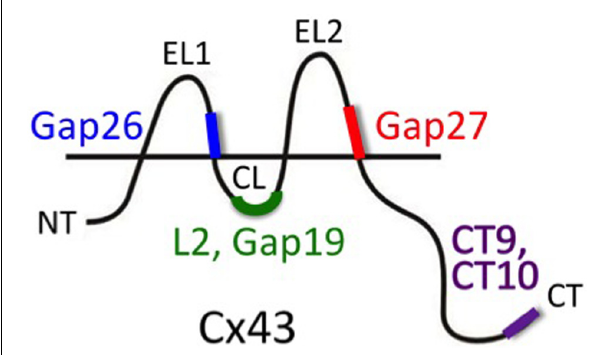
FIGURE 2 | Peptide tools to interfere with Cx hemichannel function. Gap26 and Gap27 are composed of sequences located on the extracellular loops 1 (EL1) and 2 (EL2), respectively (amino acids 64–76 and 201–210, respectively) of Cx43 (mouse).These EL-mimetic peptides first inhibit hemichannels and with some delay also gap junction channels.The sequences they mimic are well conserved between different Cxs and peptides based on Cx43 sequences could also inhibit channels composed of other Cxs (e.g., Cx37). L2 peptide is identical to the L2 domain on the cytoplasmic loop (CL; amino acids 119–144). Gap19 is a nonapeptide located within the L2 domain (amino acids 128–136). L2 and Gap19 peptides block Cx43 hemichannels without blocking gap junctions and without blocking Cx40 hemichannels or Panx1 channels (other Cxs still need to be tested). CT10 and CT9 are the last 10 and last 9 amino acids of the C-terminal end (CT; amino acids 373–382 and 374–382, respectively). CT9/CT10 peptides remove the closure of Cx43 hemichannels with high micromolar cytoplasmic Ca 2 + concentration and thus stimulate the opening of hemichannels.This particular effect of the CT-peptides is independent of the last amino acid (isoleucine 382) that is involved in linking Cx43 to scaffolding proteins involving ZO-1 interactions (the amino acid sequence 374–381 has the same effect as CT9/CT10; De Bock etal.,